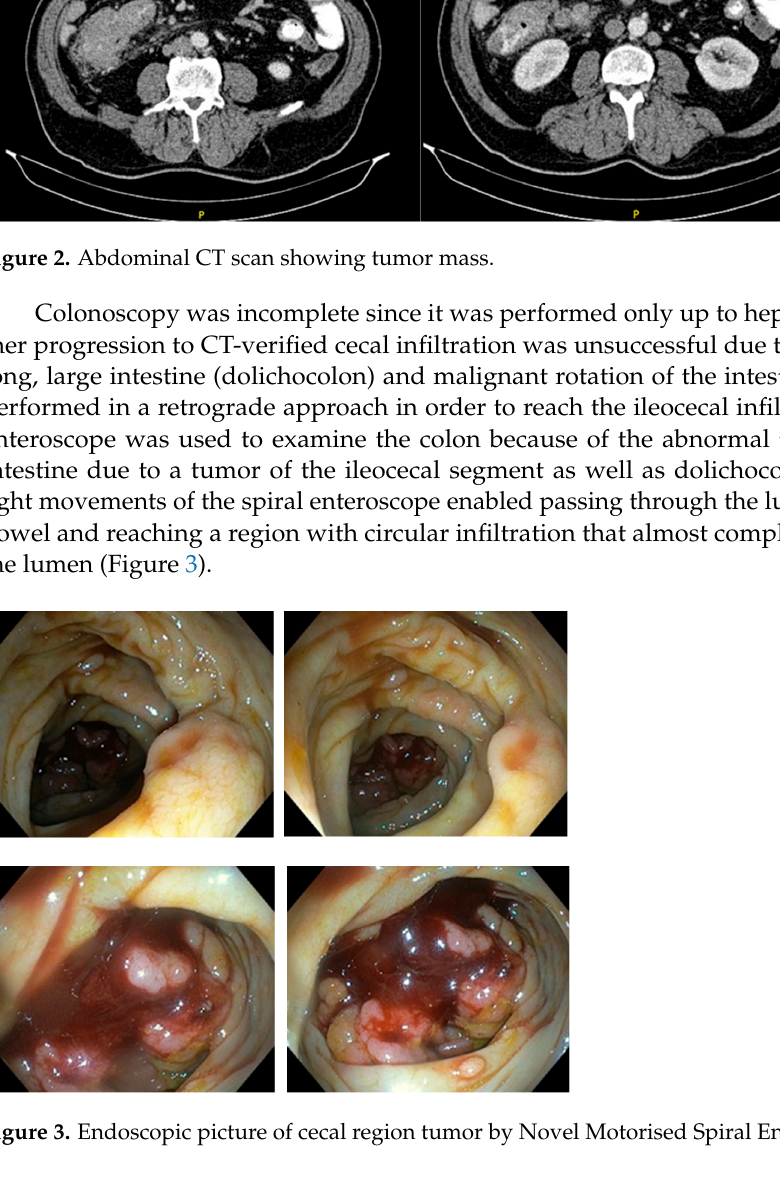
Figure 4. Microscopic images of cecal adenocarcinoma. 3. Discussion The small bowel and ileocecal segment diseases accompanied by pathological intes- tinal tortuosity have always been a significant drawback for endoscopists. In the last two decades, with the introduction of DBE in 2001 and SBE in 2006, enteroscopic examination has significantly improved [1,19–21]. Video capsule endoscopy was found to be useful for the visualization of the entire small bowel. However, it does not allow the performing of therapeutic interventions and biopsies, which represents a significant limitation of this procedure [22]. The NMSE is a revolutionary endoscopic tool for the diagnosis and ther- apy of distant areas of the gastrointestinal tract that are inaccessible by proximal and distal endoscopy. Therefore, it is extremely useful for examination and interventions in the deep parts of the small bowel [23]. In this case, NMSE enabled a complete visualization of the colon and reached the ileocecal infiltration quickly and efficiently by “pleating” the ab- normally long, tortuous colon. In addition, this technique allowed the performing of con- trol movements of the endoscope and provided a more stable position for obtaining rep- resentative biopsies compared to the conventional colonoscope. The available literature mainly deals with the usage of this procedure for the diagno- sis and treatment of small bowel diseases since it has been primarily developed for that purpose. However, some authors have reported the benefits of using this technique in cases when conventional colonoscopy is unsuccessful.